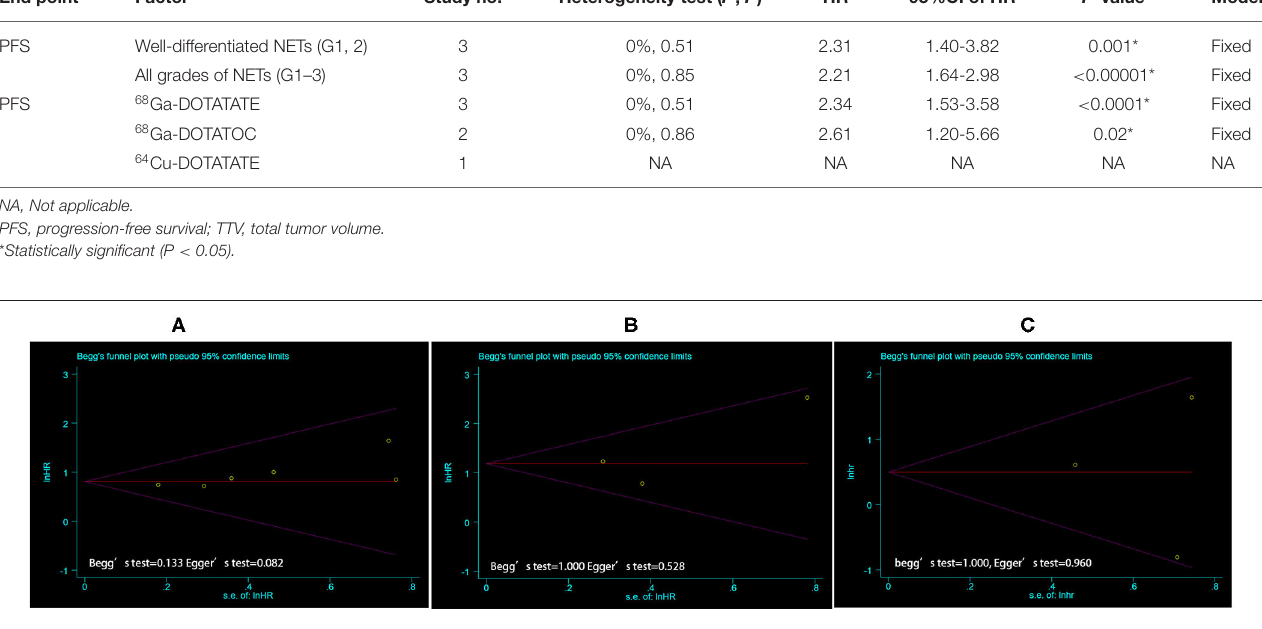
FIGURE 3 | The funnel plot of publication bias estimates the results of PFS (A) and OS (B) based on TTV, and PFS based on TL-SSTR (C) in the meta-analysis. Egger’s test and Begg’s test were used for statistical analysis, where the P < 0.05 was considered as significant. PFS, Progress free survival; OS, overall survival; TTV, total tumor volume; TL-SSTR, total-lesion somatostatin receptors